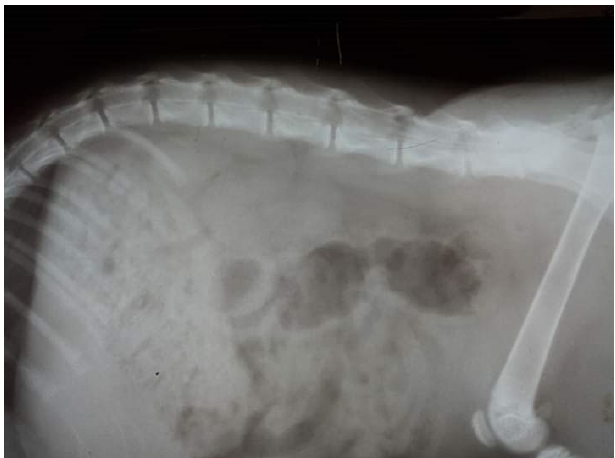
Figure 2. The myelography showed filling defect of contrast medium (Omiplaque) L6, and L7 area (case 1)